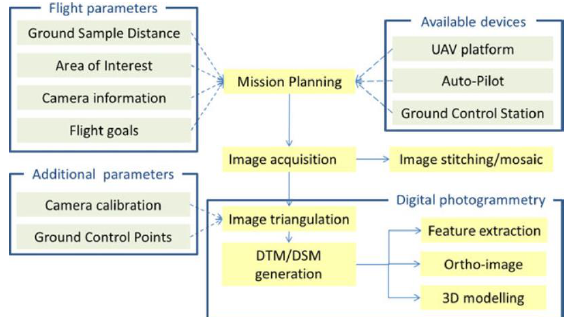
Figure 3 : UAV Acquisition Workflow (Nex and Remondino,